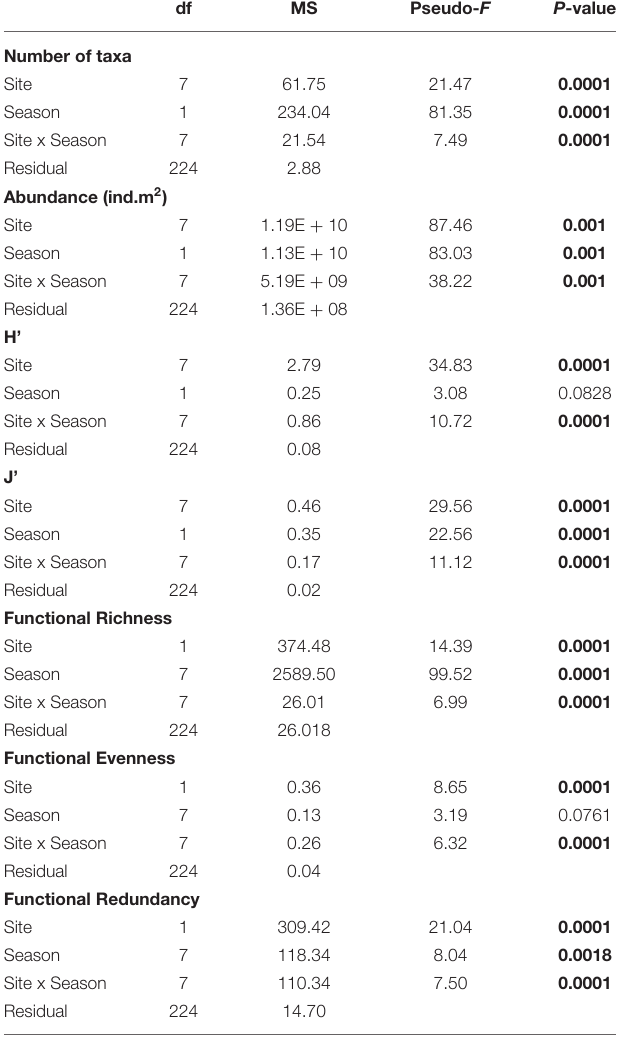
TABLE 3 | Test results from univariate one-way fixed factor PERMANOVA to compare number of taxa (richness), abundance, Shannon diversity index